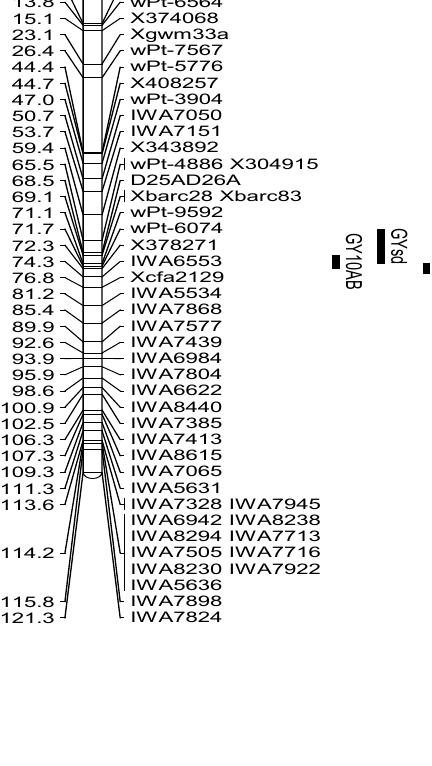
Figure 2. Distribution of QTL for grain yield (GY), heading date (HD), plant height (HT) and three traits related to genotype × environment interactions (IPC1, IPC2 and GYsd). IWA66440.0 XLMW113.4 wPt-656413.8 X37406815.1 Xgwm33a23.1